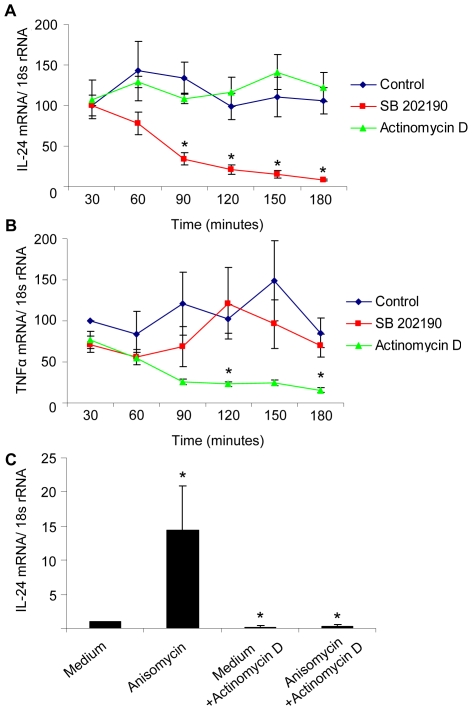
p38 MAPK regulates IL-24 expression at a posttranscriptional level.(A and B) NHEK were pre-stimulated with anisomycin (300 ng/ml) for 2 hours at which point medium (control), the transcription inhibitor actinomycin D, or SB 202190 were added to the cultures. Cells were then harvested at 30 minute intervals, total RNA extracted and (A) IL-24 and (B) TNFα-mRNA levels (relative to 18 s RNA) were determined. *p<0.05 compared with control (n = 5). Points indicate mean ± SD. (C) As control NHEK were pre-incubated with or without actinomycin D for one hour before treatment with medium or anisomycin (300 ng/ml) for another 2 hours. Total RNA was extracted IL-24 mRNA levels (relative to 18 s RNA) were determined. *p<0.05 compared with medium control (n = 4). Bars indicate mean ± SD.